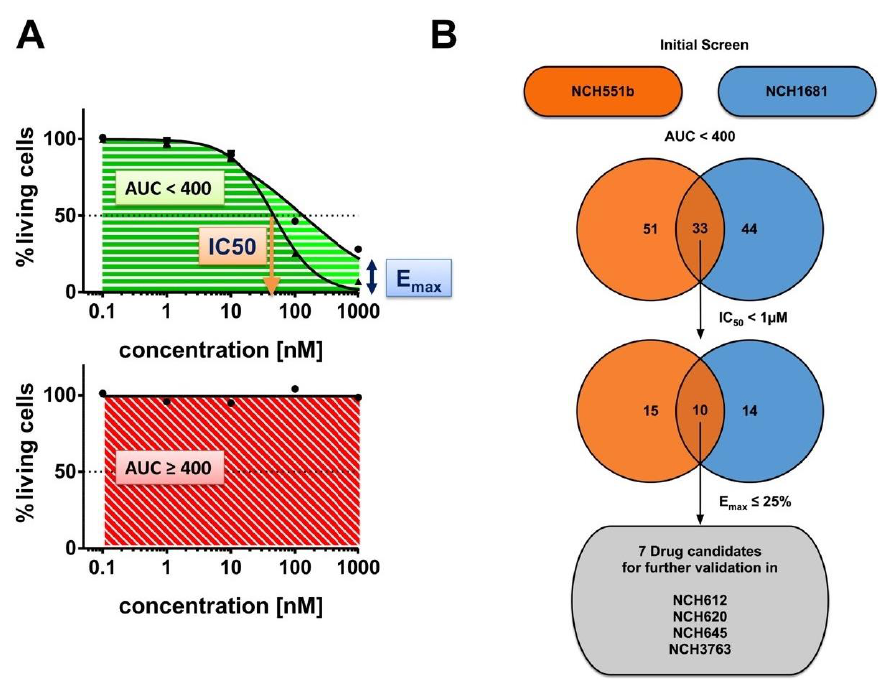
Figure 2. Drug screening workflow. A total of 147 Food and Drug Administration (FDA)-approved drugs were tested in two isocitrate dehydrogenase (IDH) mutant (IDH mut ) glioma stem cell (GSC) lines (NCH551b, NCH1681) in a 5-dose primary screen. ( A ) The following drug response parameters were analyzed: area under the curve (AUC), half-maximal inhibitory concentration (IC 50 ), and maximal inhibitory effect (E max ). ( B ) Drugs which first showed an AUC < 400 ( n = 33) and secondly an IC 50 < 1 µM ( n = 10) in both cell lines were then ultimately filtered for an E max ≤ 25%. Candidate drugs were successfully tested in four additional IDH mut GSC lines (NCH612, NCH620, NCH645, NCH3763) in a 7-dose secondary validation.